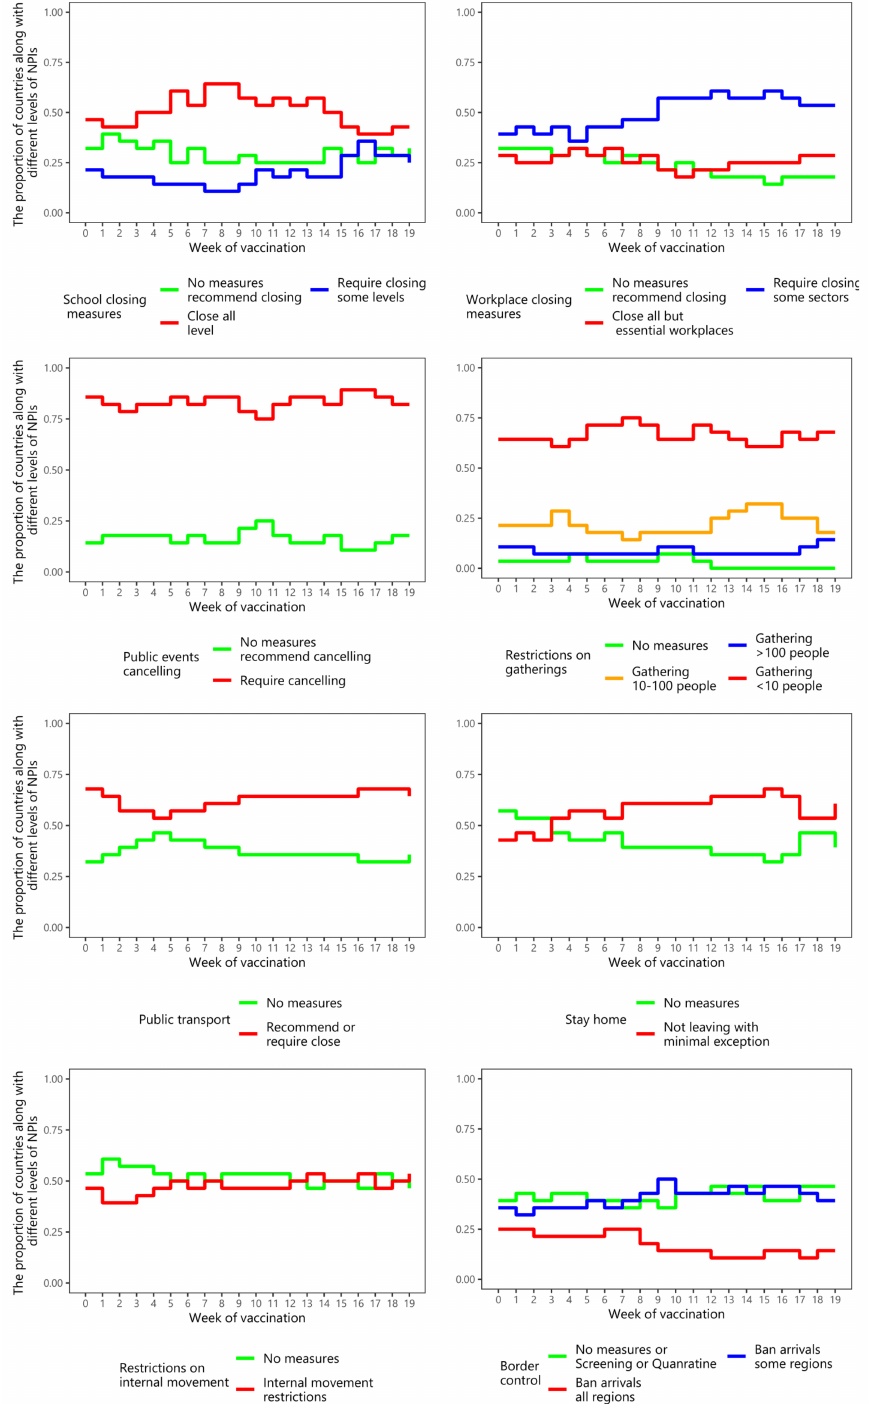
Figure 6. The proportion of countries implementing different intensities of NPIs over the 20 weeks among Asian countries during the post-vaccination